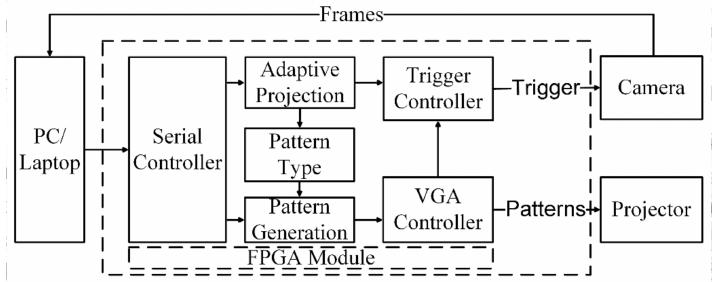
Figure 3. Block level representation of the complete architecture implemented on FPGA which contains the synchronization, adaptive rate pattern generation and camera trigger controller